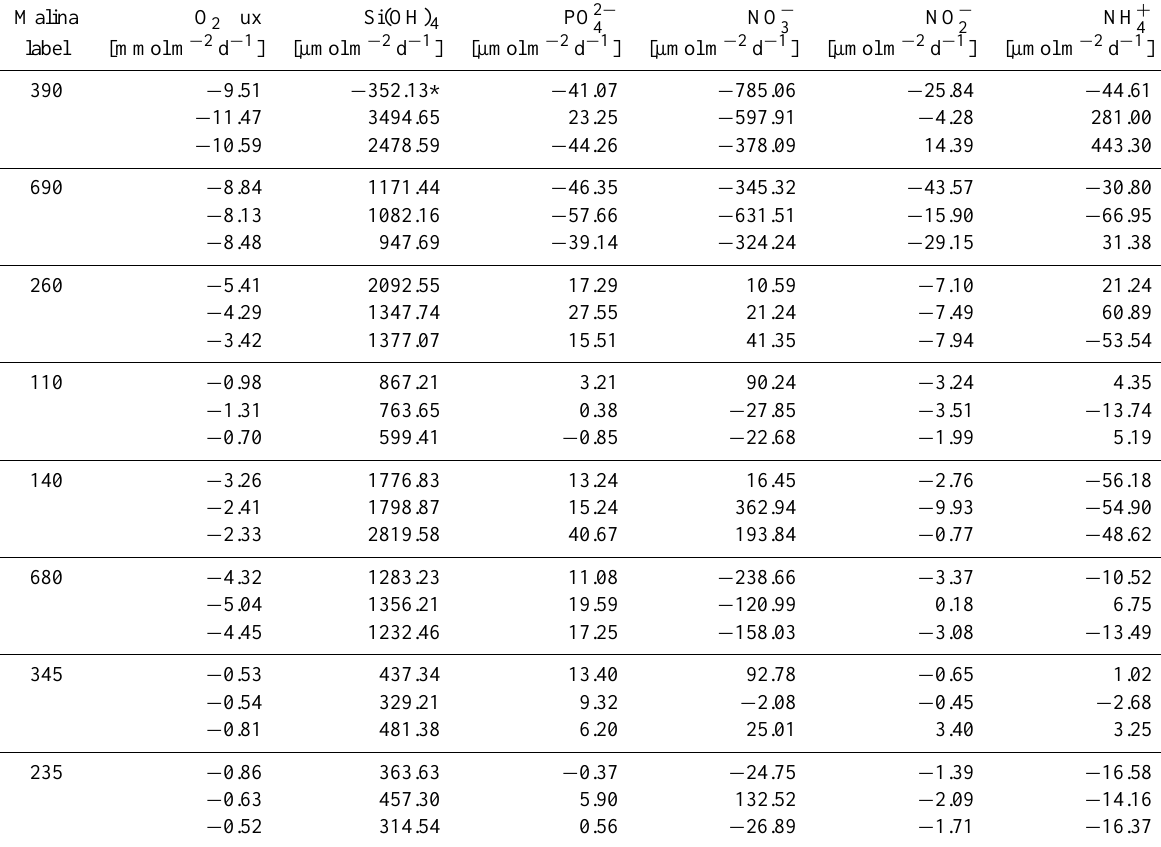
) , nitrate (NO − ) , nitrite (NO − ) , and ammonium (NH + 4 3 2